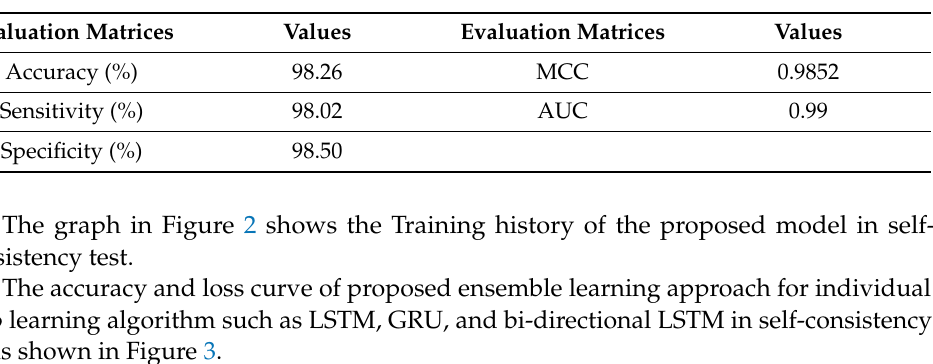
Table 3. Results of proposed ensemble learning model with 10-fold cross validation